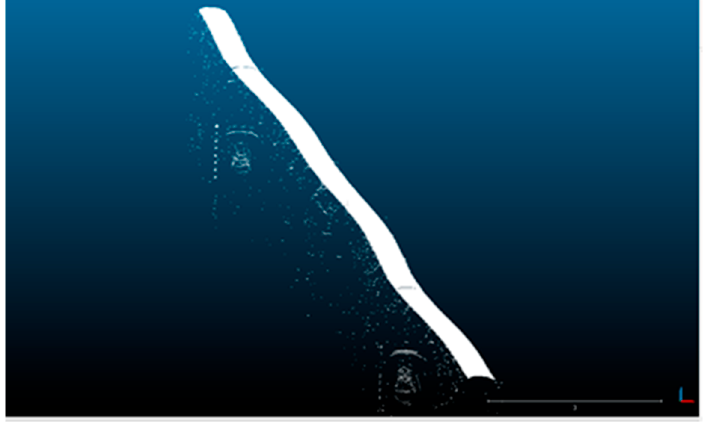
Figure 7. Point cloud of multiple lines of valid height signals at the edge of the scanned wafer. To further reduce the influence of the fluctuation of edge distance serial D val on eccentricity measurements, the mapping between the rotation angle and the edge distance is obtained by fitting the edge distance with the corresponding wafer edge position. The selection of the regression model has a direct impact on the measurement accuracy